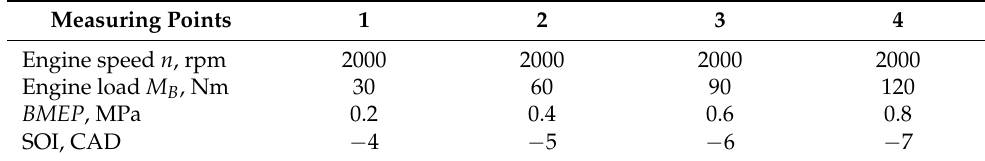
Table 3. Engine load and start of fuel